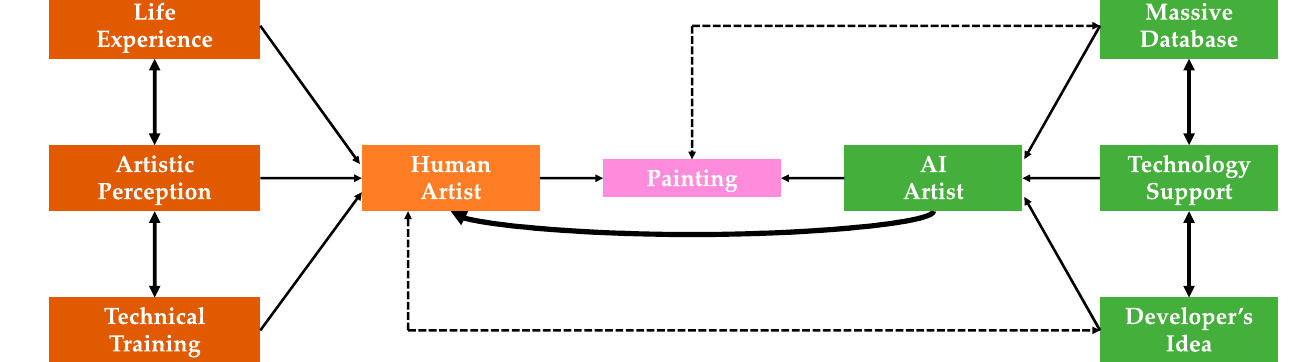
Figure 7. The similarities and differences between the creative models of human and AI